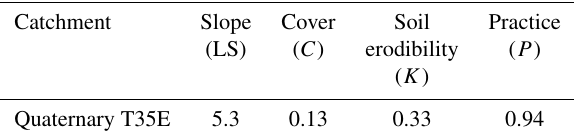
Table 2. Practice factor ( P ) for the Ntabelanga Dam catchment. Land cover/use type